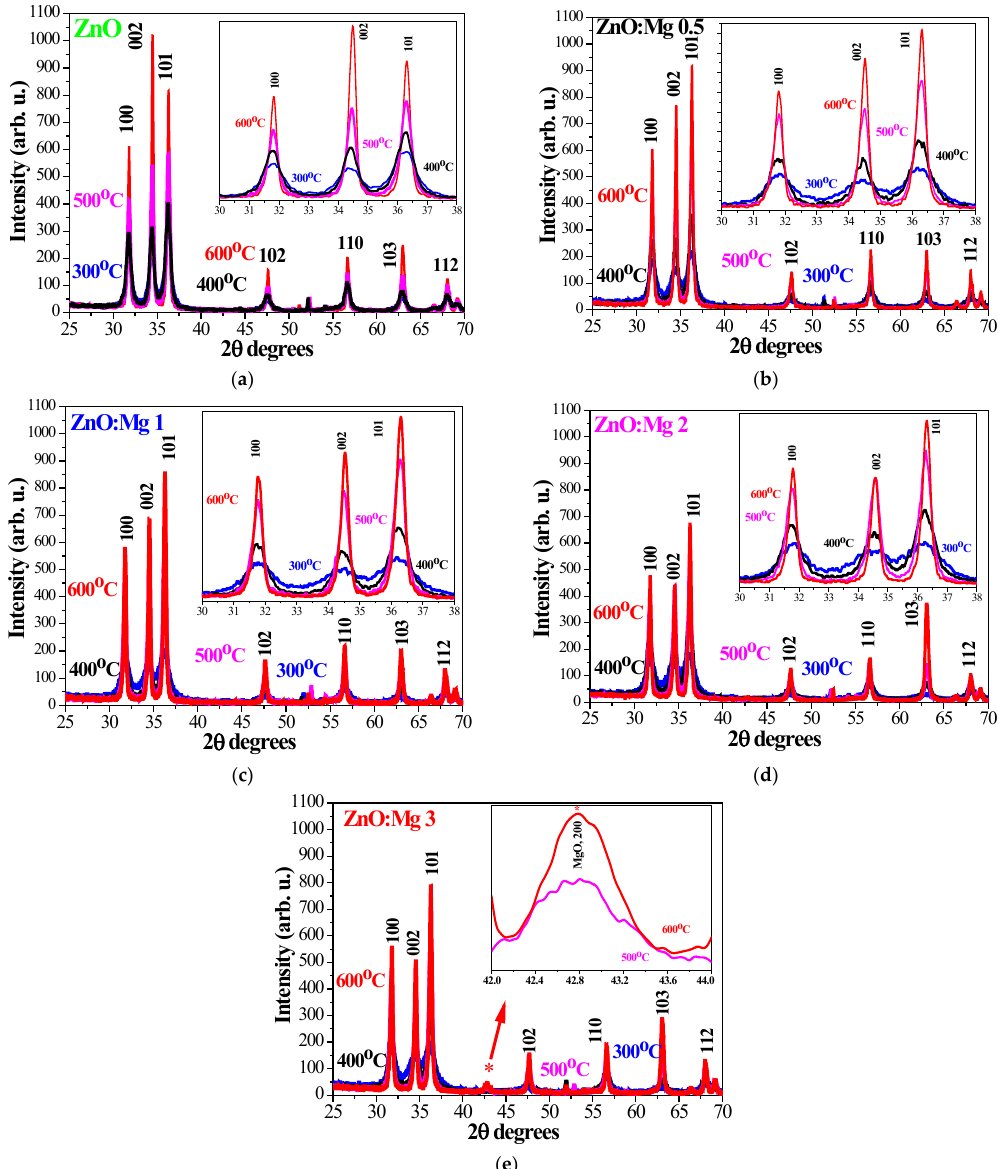
Figure 1. XRD patterns of the sol–gel ( a ) ZnO, ( b ) ZnO:Mg 0.5, ( c ) ZnO:Mg 1, ( d ) ZnO:Mg 2 and ( e ) ZnO:Mg 3 thin films, treated at temperatures of 300–600 °C. The asterisk symbol * indicates MgO. The inset pictures in ( a – c ) are the enlarged patterns in the range of 30–38°. The inset in ( e ) presents the appearance of the MgO phase, 42–44°. The film crystallization deteriorates with increasing Mg concentrations. It is ob- served that with increasing magnesium concentrations, the intensity of the XRD peaks decreases, as seen from Figures 1 and 2.